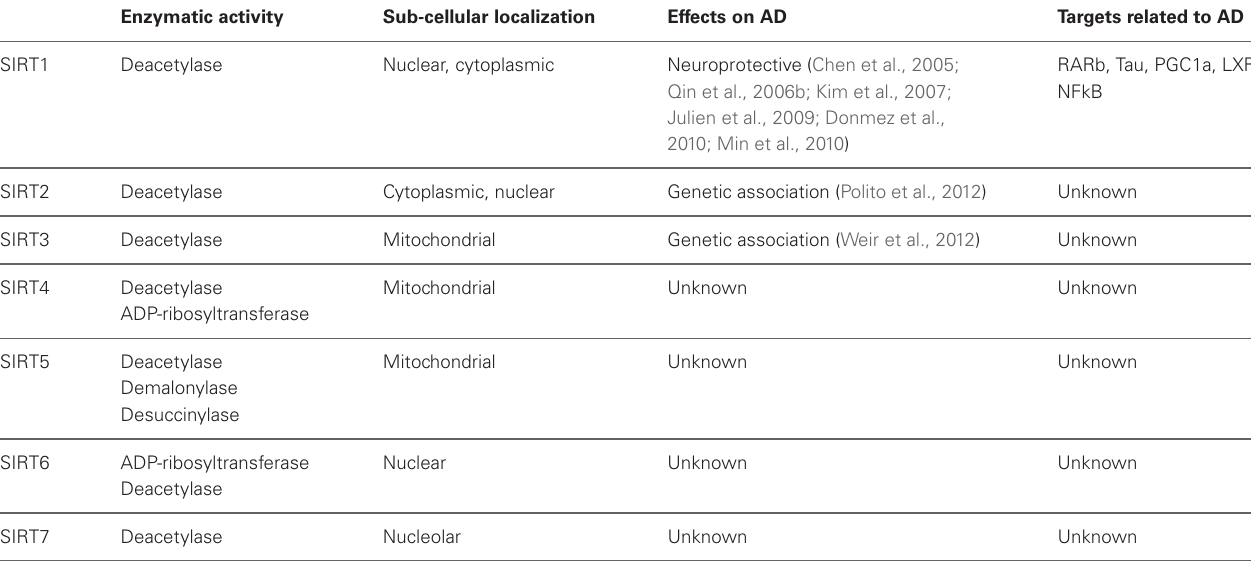
Table 1 | Activity and localization of mammalian sirtuins and their effects on